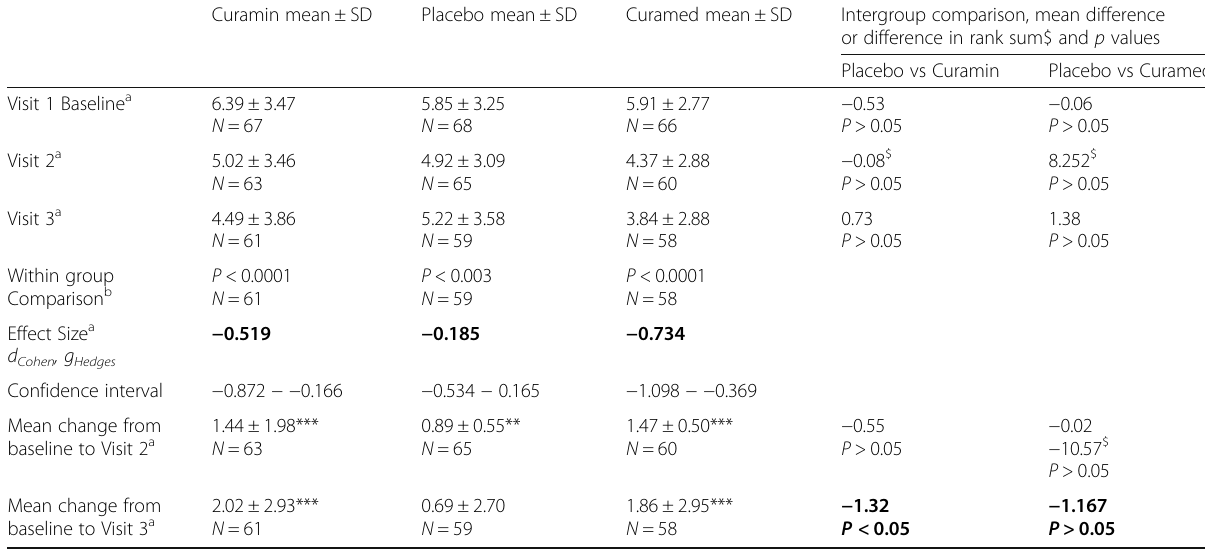
Table 5 Within (columns) and between (lines) groups comparison of WOMAC Pain Index subscale Curamin mean ± SD Placebo mean ± SD Curamed mean ± SD Intergroup comparison, mean difference or difference in rank sum$ and p values Placebo vs Curamin Placebo vs